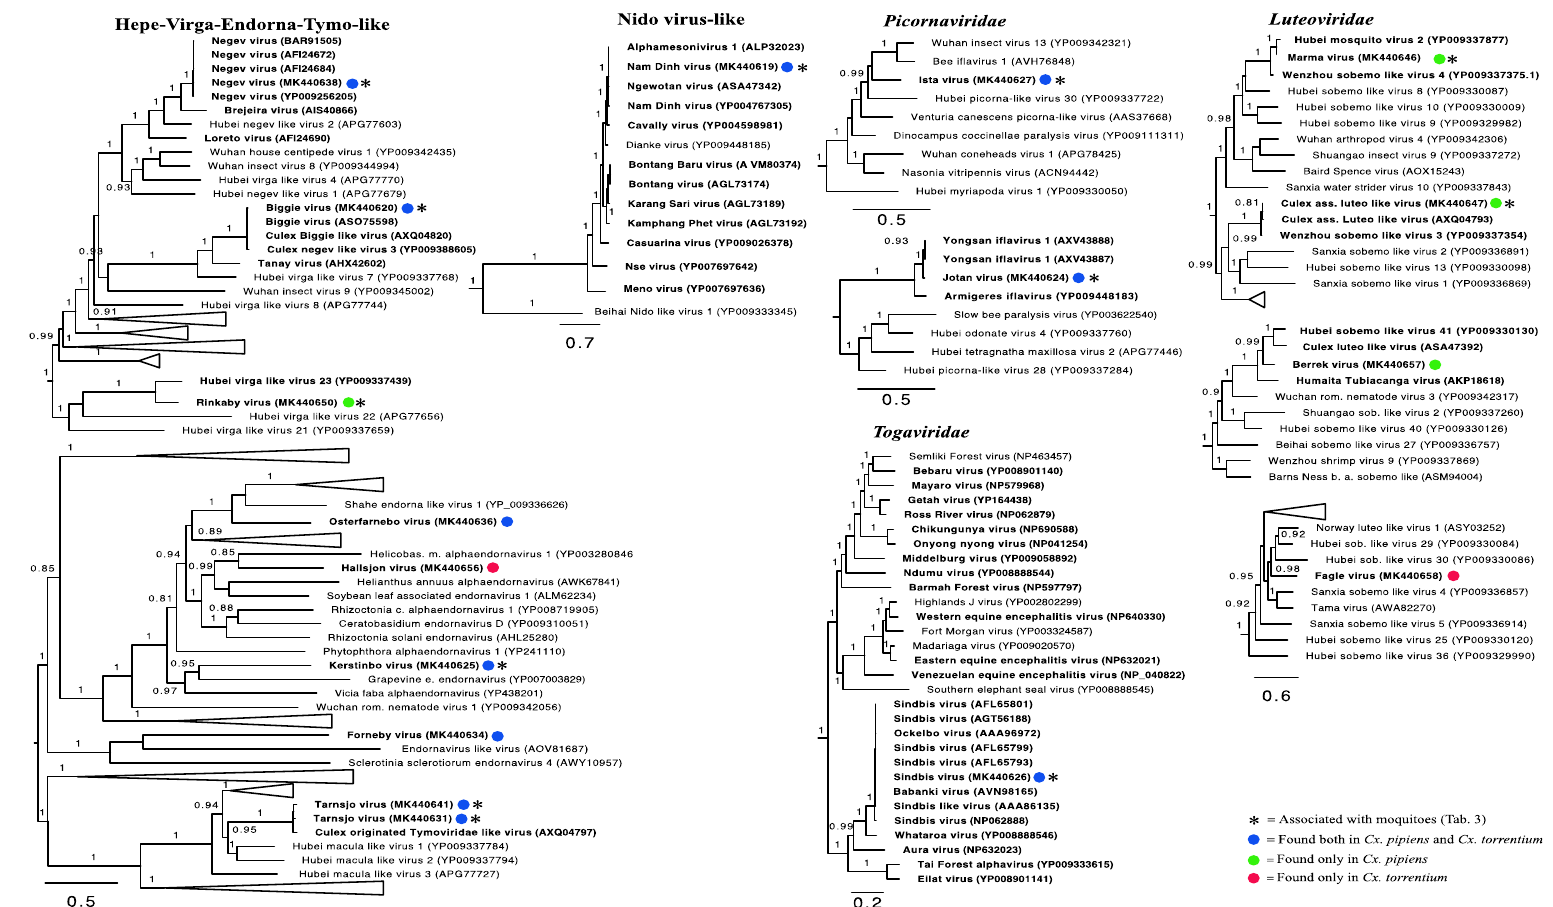
1 Figure 4. Phylogenetic analysis of all the positive-sense RNA viruses identified here (marked by colored circles) along with representative publicly available viruses. Those viruses most likely associated with mosquitoes are marked by an *. Numbers on branches indicate Shimodaira–Hasegawa (SH) support, and only branches with SH support ≥ 80% are indicated. Branch lengths are scaled according to the number of amino acid substitutions per site. All phylogenetic trees were midpoint-rooted for clarity only. Known mosquito-associated viruses and virus sequences that were derived from mosquito samples are indicated in